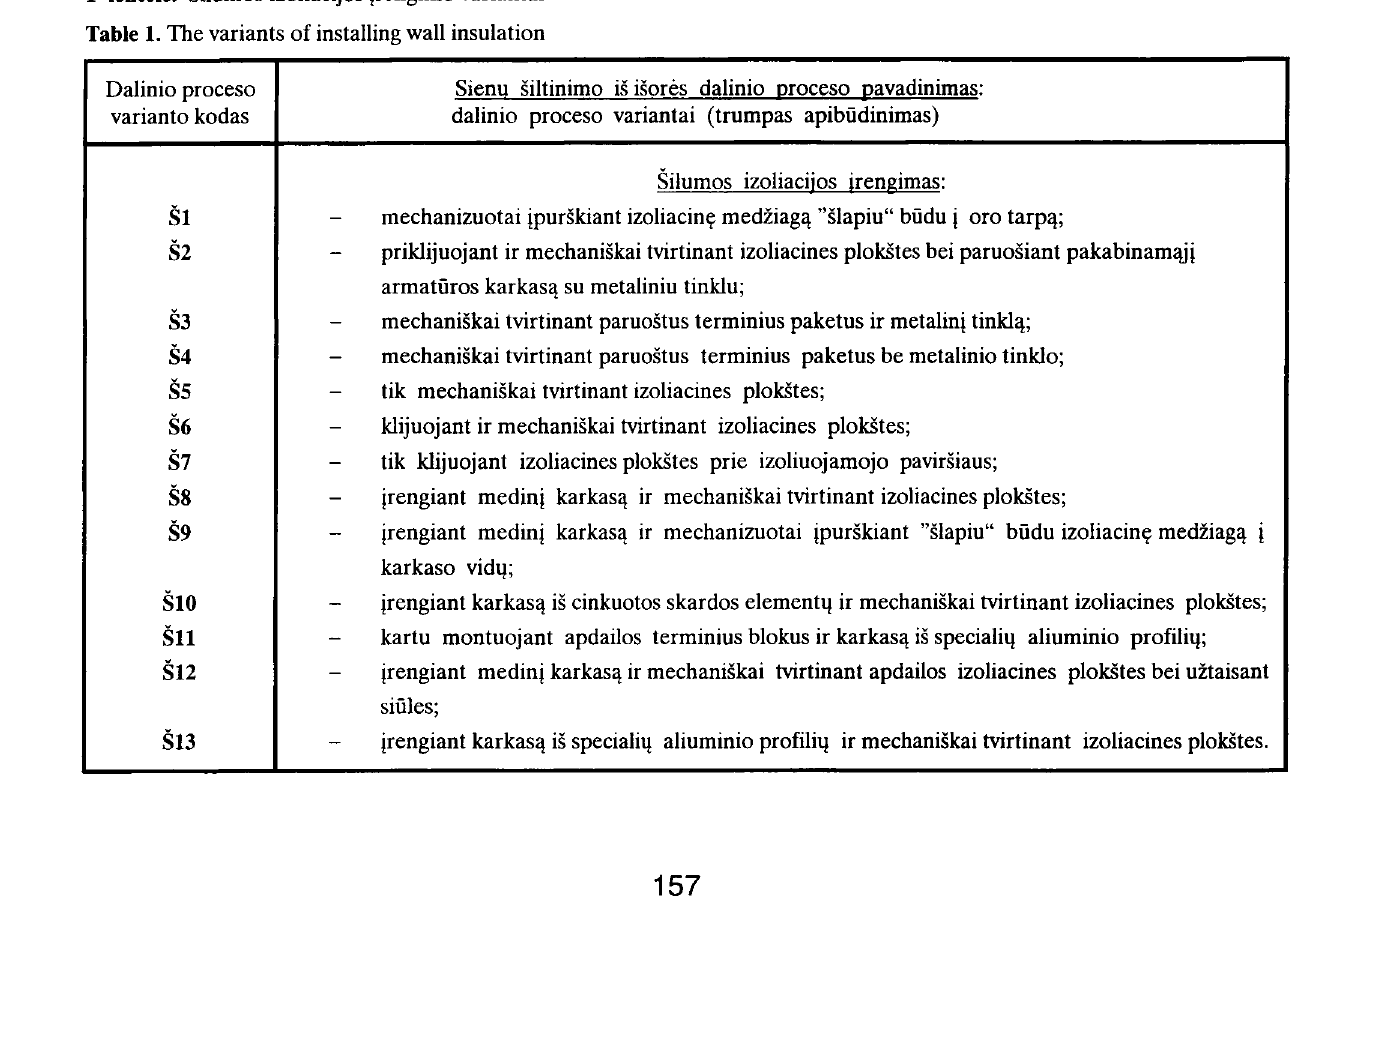
Fig 3. The possible combinations of wall insulation from outside IS 3 pav. matyti, kad sienq siltinimo is isores